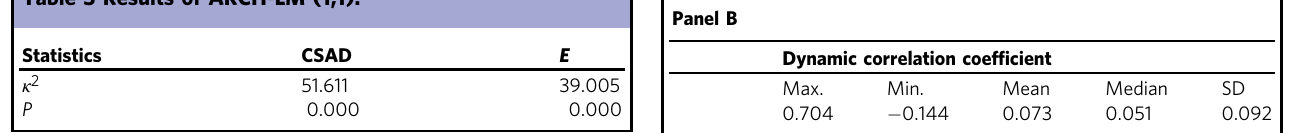
Table 3 Results of ARCH-LM (1,1).